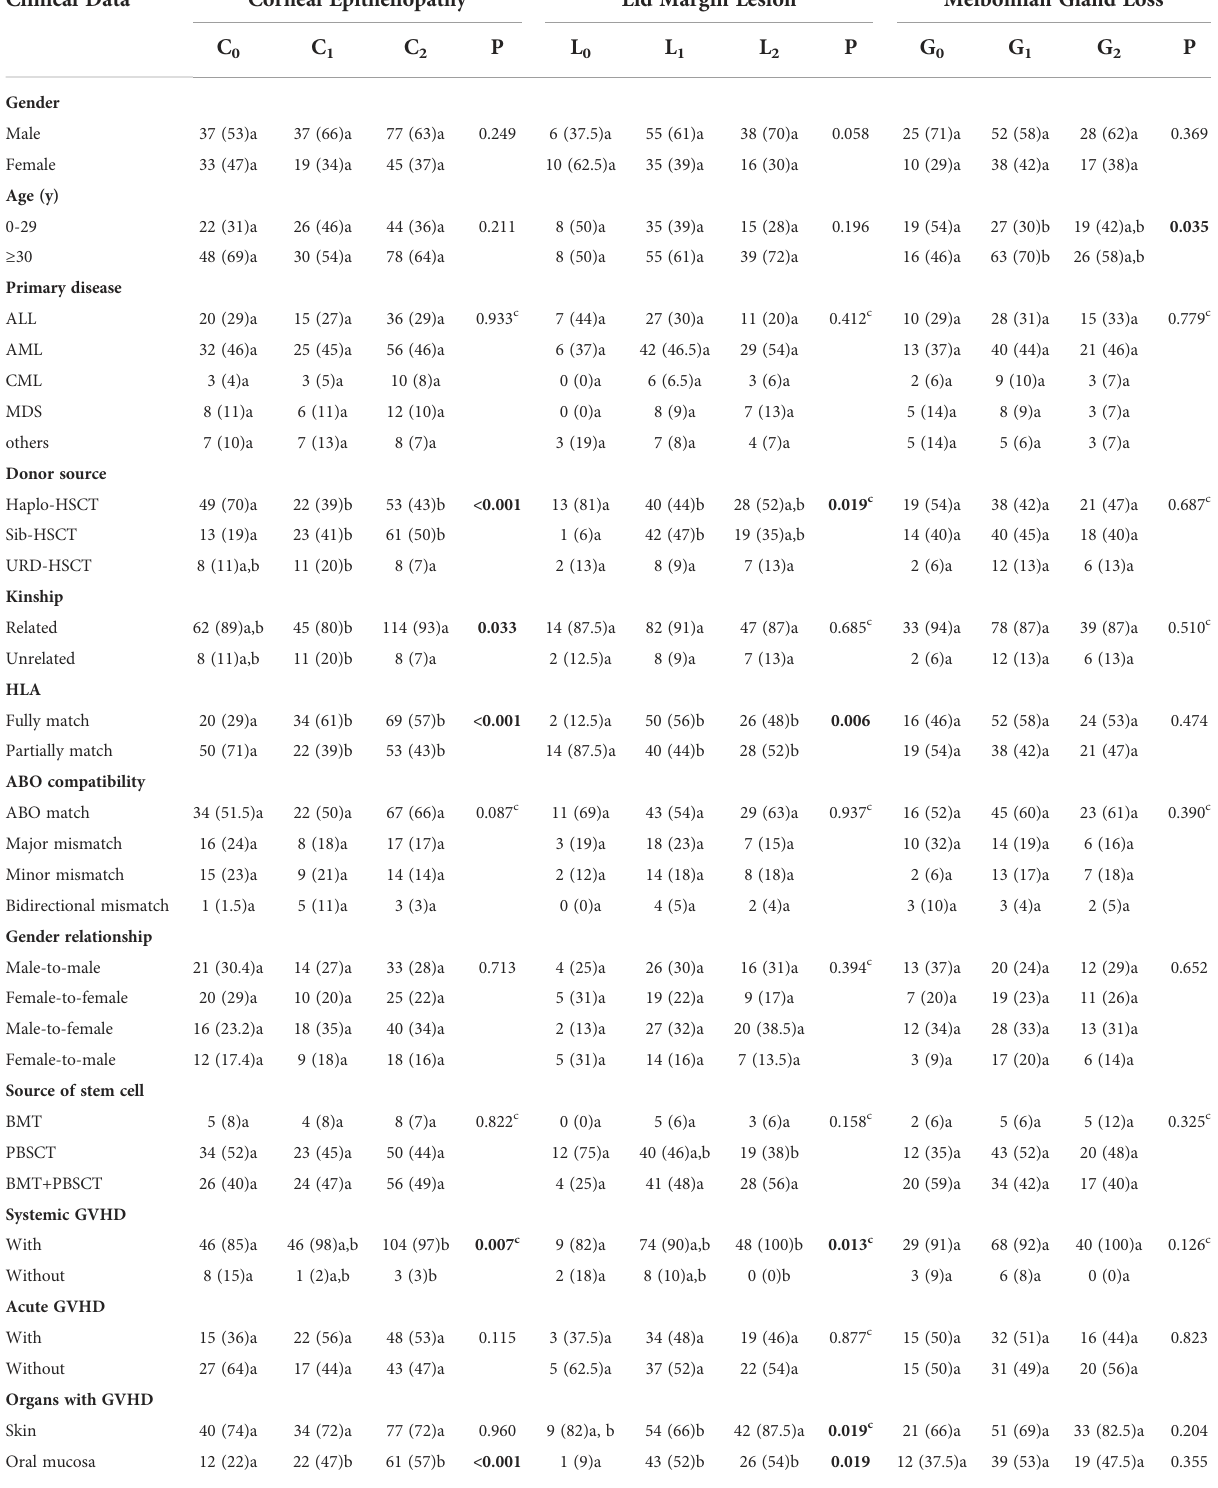
TABLE 3 Univariate analysis of ocular surface lesions. Clinical